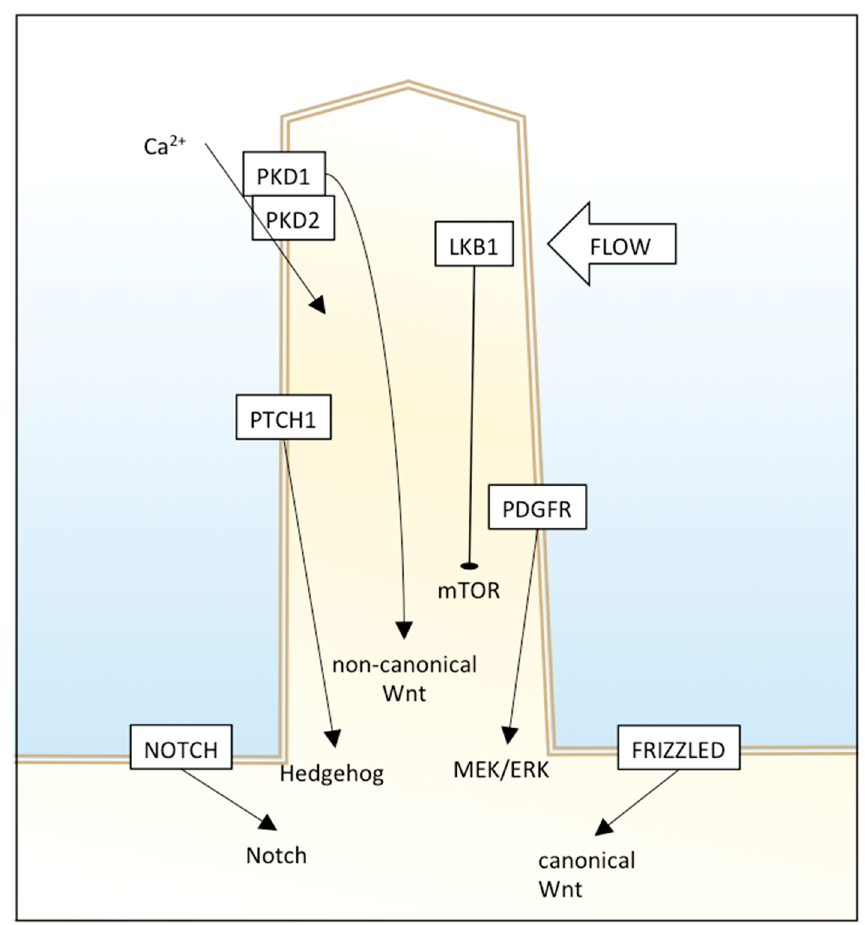
Figure 1. The primary cilium is a “central processing unit” of the cell that integrates different extracellular signals to regulate cell functioning. Different signaling pathways are shown.